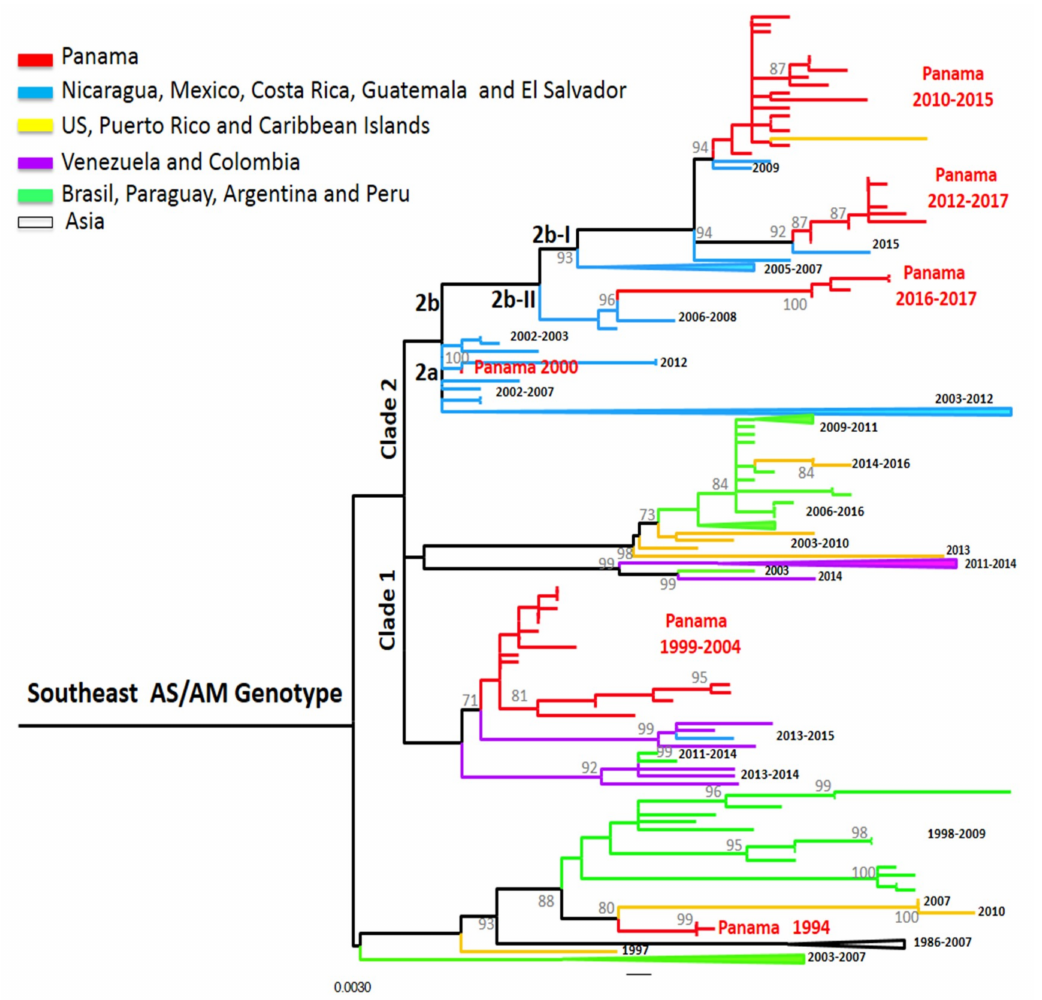
Figure 3. Maximum-likelihood (ML) consensus tree of the Envelope (E) protein gene of DENV-2. The ML tree was constructed using the model General Time Reversible (GTR + I + gamma), showing bootstrap values > 70 (1000 replicates). Blue color represents DENV-2 Panamanian strains ( n = 53). DENV-2 was detected again in Panama from 1999 to 2005 and was the only detected serotype from 2001–2002. DENV-2 isolates from 1999–2004 grouped in a cluster divided into two smaller clusters, related to Colombian strains within the AS / AM clade 1 [18] (Figure 3). However, the strain PA / DENV-2 / GMI482608 / 2000 was closer to strains sampled in Mexico, Guatemala, and El